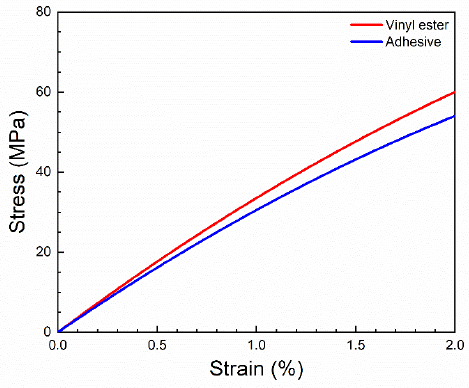
Figure 6. Established stress–strain curves of epoxy adhesive and vinyl ester matrix, shown in the relevant strain range. See approach in Appendix A.